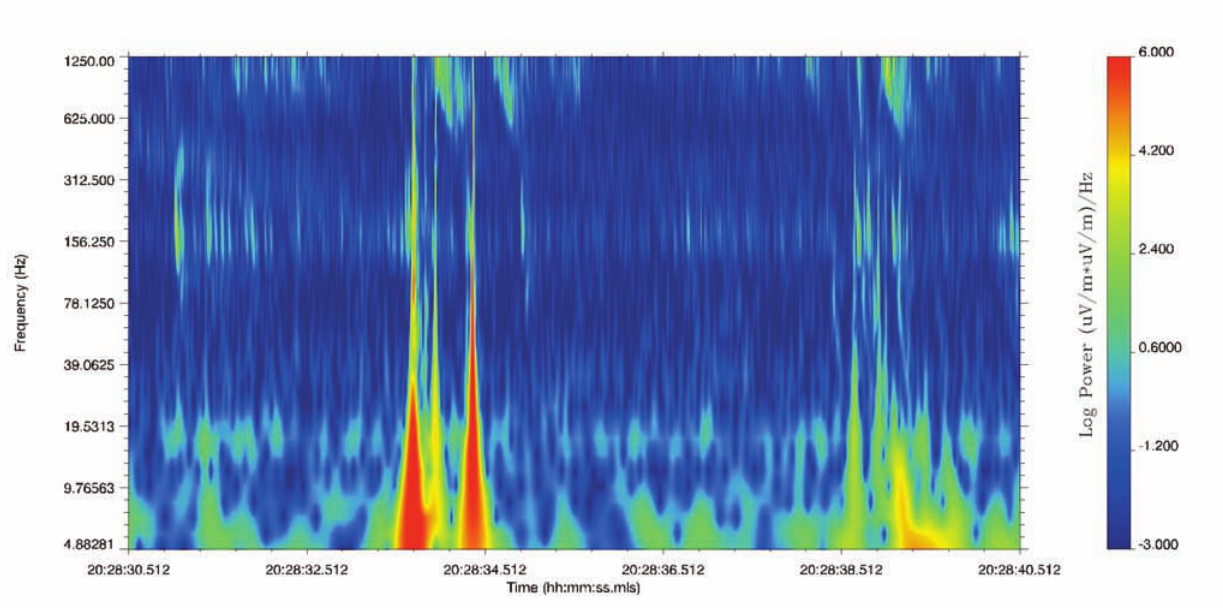
Figure 7a. Wavelet spectrogram of the broad-band emission in the ELF range recorded on April 4, 2009. The distance of the footprint of the satellite to the epicenter was about 280 km. The color scale is as in Figure